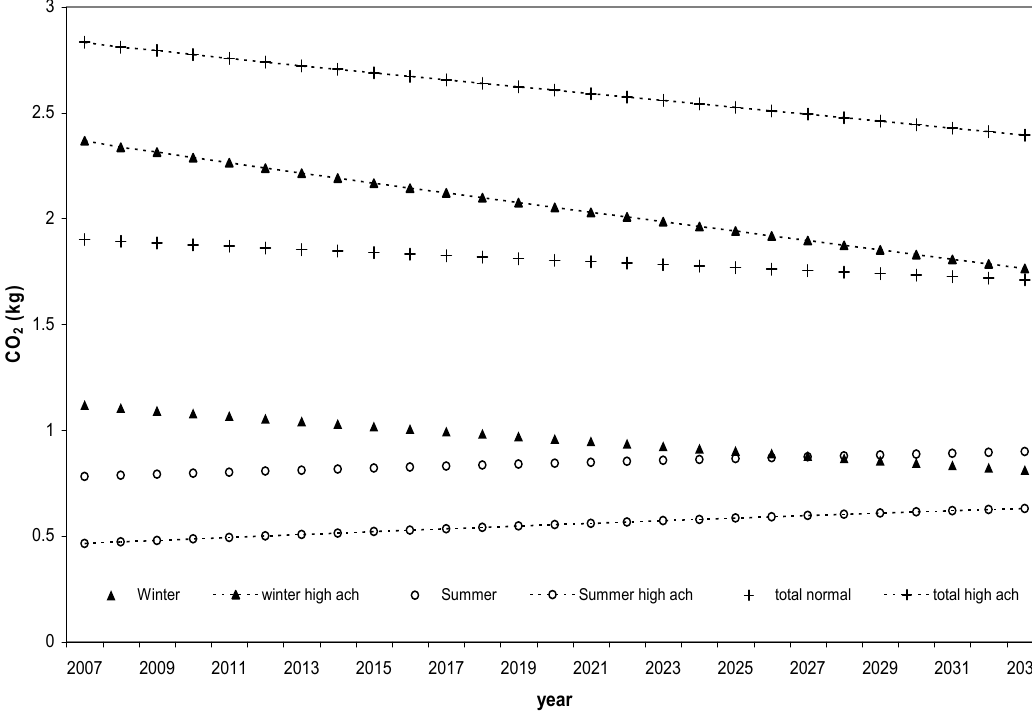
Figure 8. Utilization factor ( h ) for different air changes value.